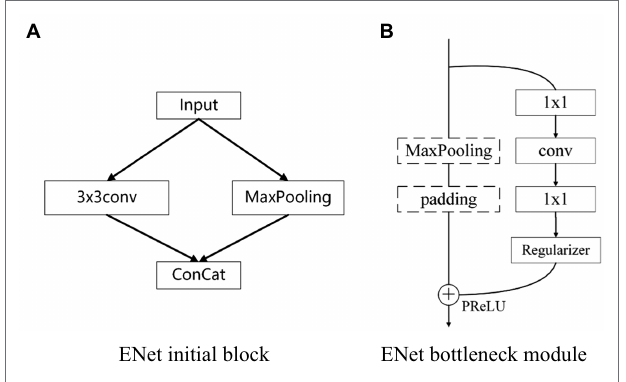
FIGURE 1 | Module structure